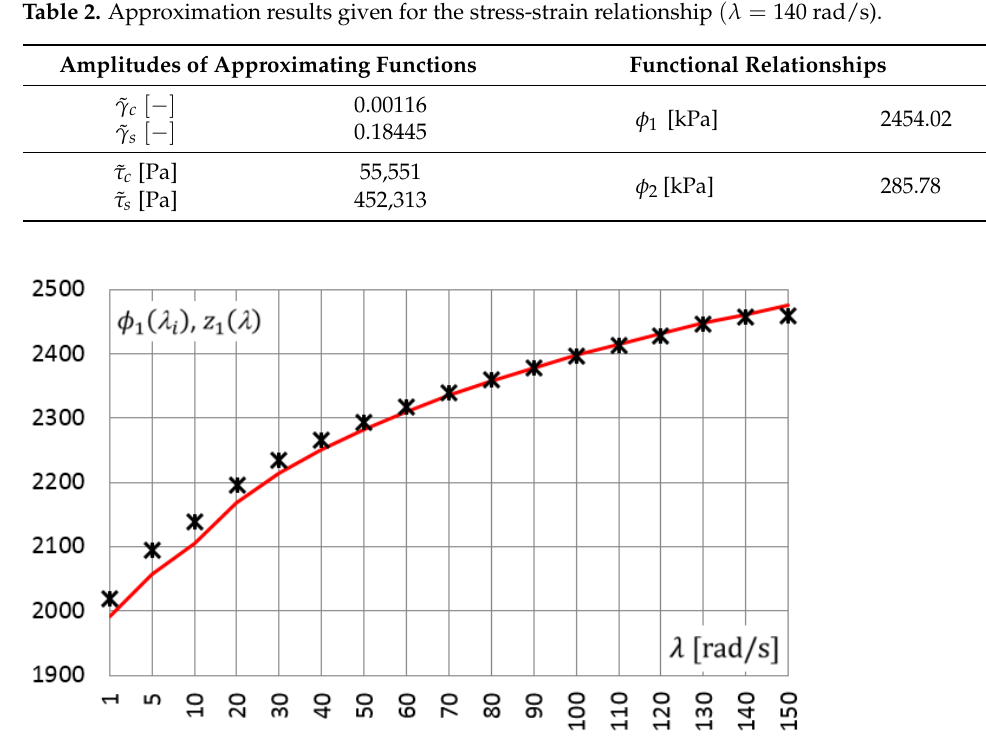
Figure 10. Functional relationships for selected frequencies: φ 1 ( λ i ) —obtained from laboratory test (points), z 1 ( λ ) —derived for Zener model (solid line).